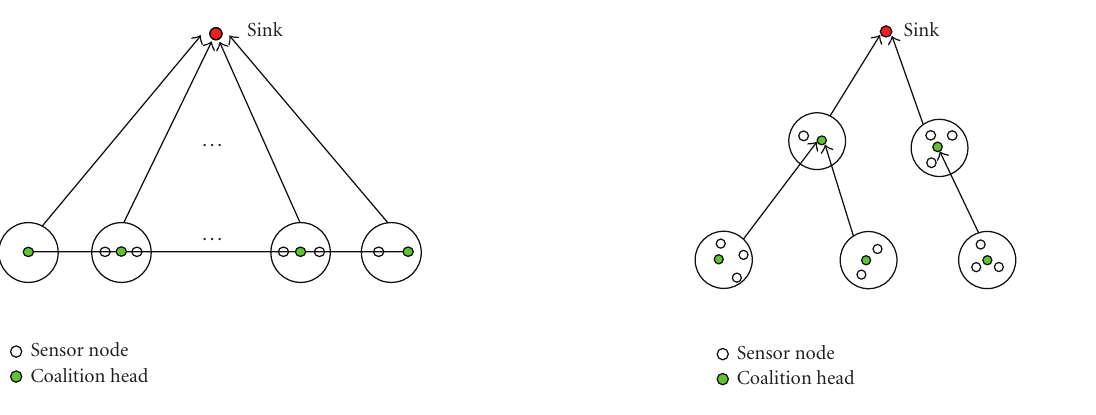
Figure 1: A many-to-one sensor network. Figure 2: A multihop sensor